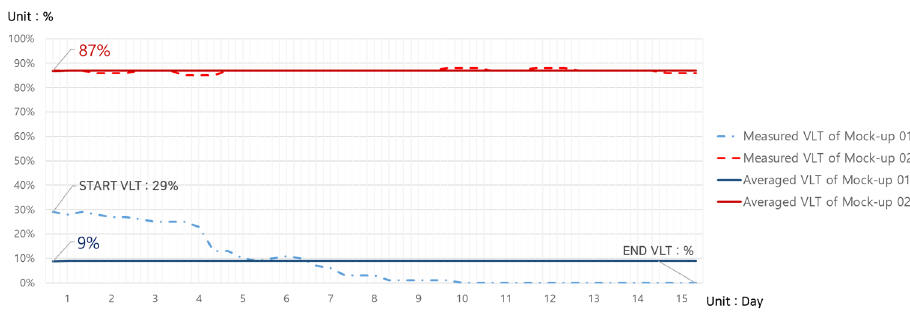
Figure 10. VLT changes of mock-up 01 and 02 in autumn season.